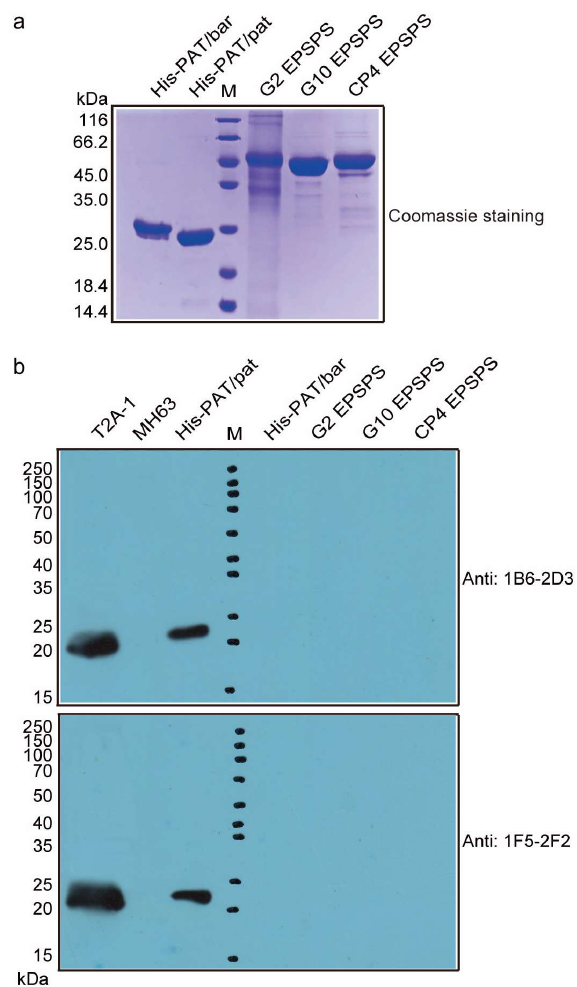
Figure 4. Specificity of anti-PAT/pat mAbs. ( a ) SDS-PAGE stained with Coomassie Blue, pro- tein marker (26610, ThermoFisher Scientific) and ( b ) Western blotting of PAT/pat in C0010.3.1, His-PAT/pat, and other herbicide resistance proteins (PAT/bar, CP4 EPSPS, G2 EPSPS, and G10 EPSPS) against 5 µ g/mL of the mAbs 1F5-2F2 and 1B6-2D3, protein marker (P8028L, Uelandy Inc., Suzhou,